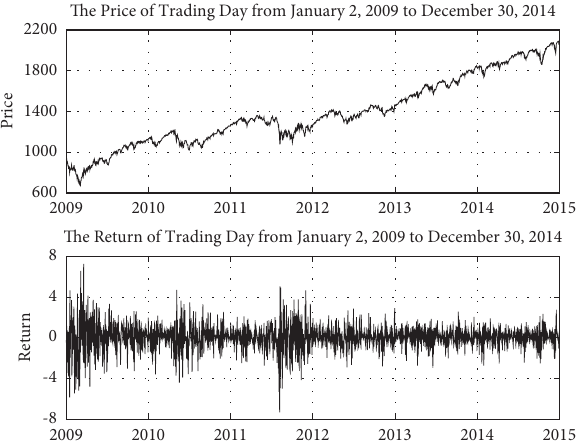
Figure 2: The S&P 500 index from January 2009 to December 2014.